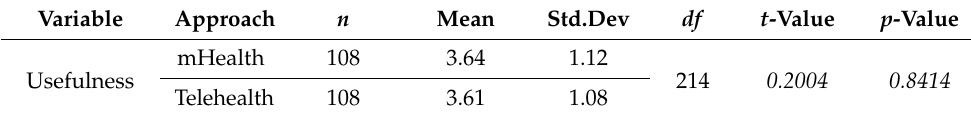
Table 3. Difference in usefulness of mHealth and Telehealth.